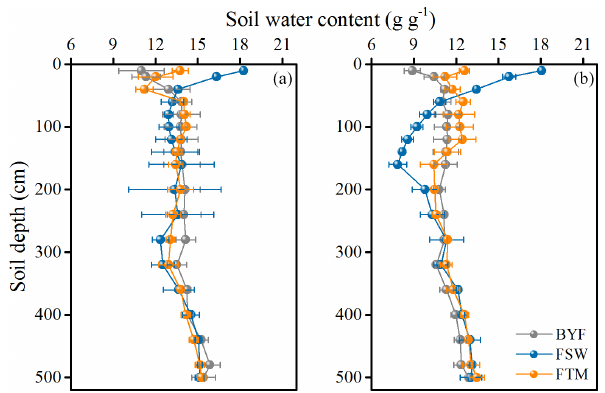
Figure 4. Vertical distribution of soil water content (SWC) before the tracer injection in 11-year-old (a) and 17-year-old (b) apple or- chards. Values are means ± SD ( N =